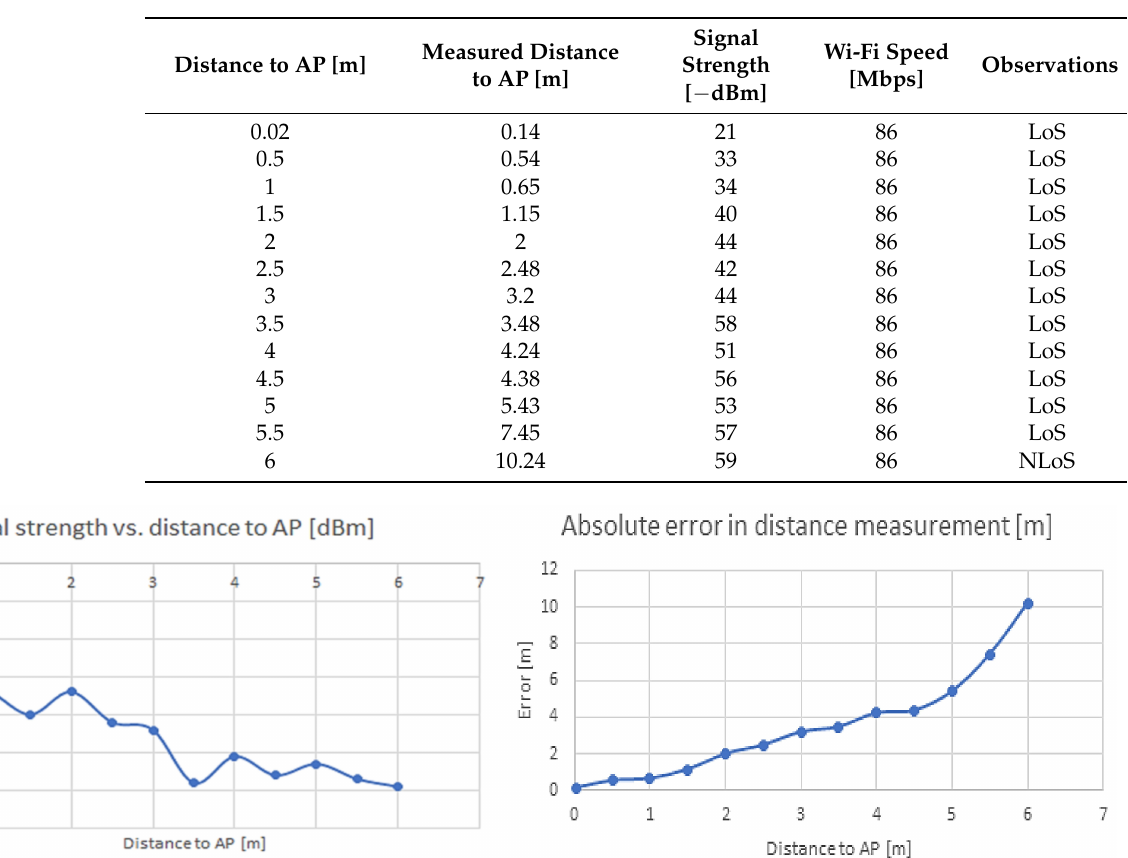
Table 5. Recorded values of received signal strength, Xiaomi AP, mixed indoor environment (LoS